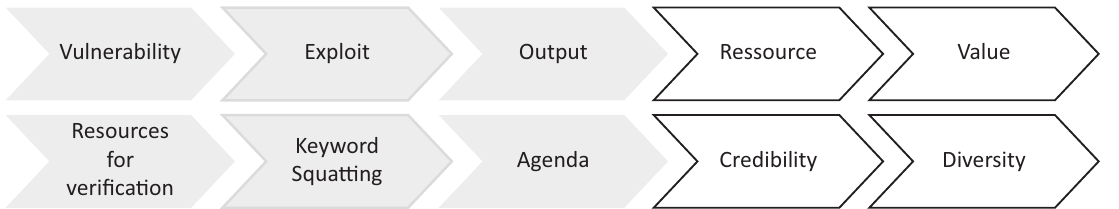
Figure 1. Parasitic attack vector. Note: The starting point is identifying a predetermined fault line or vulnerability (e.g., lack of resources, lack of competence etc.), in the case described here a lack of resources for verification of user-generated content; then an exploit is applied (keyword squatting, leak forgery, strategic controversy etc.), manipulating an output (volume, agenda or tonality of reporting) leading to resources being appropriated by the parasitic relations (e.g., infor- mation, reputation, credibility, trust, authority, attention) and values being compromised (e.g., truthfulness, rationality, representation, identity,